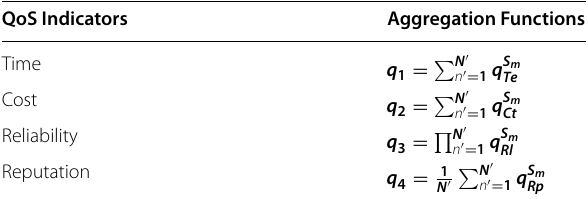
Table 2 QoS aggregation